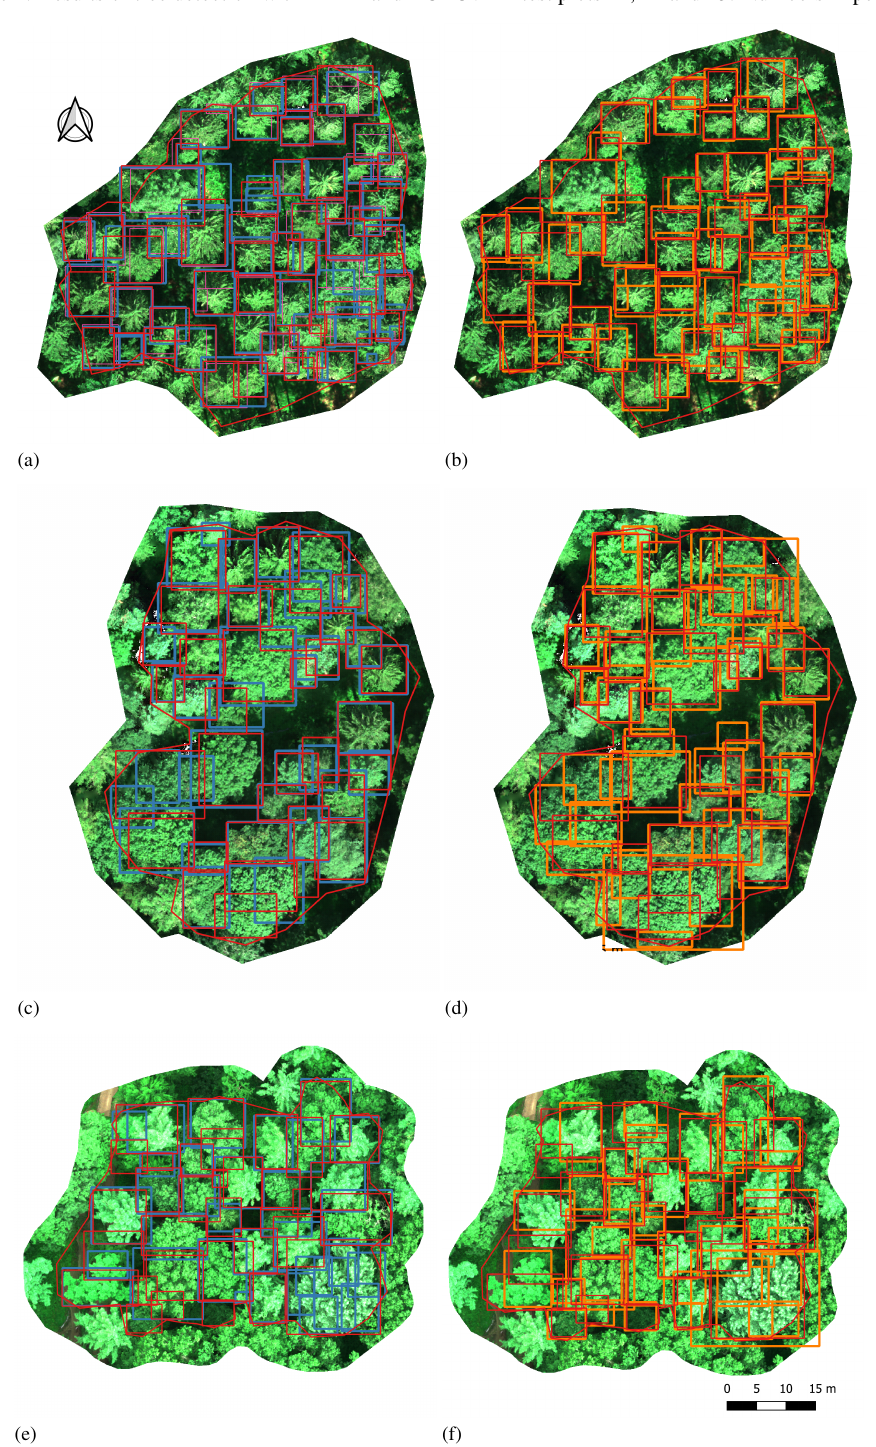
Figure 5. Results for object detection with DETR and YOLOv4. Reference data plot area surroundings are in red. Predicted bounding boxes are in blue (DETR) and orange (YOLOv4) respectively. a) Result of DETR for coniferous plot #1. b) Result of YOLOv4 for coniferous plot #1. c) Result of DETR for mixed plot #2. d) Result of YOLOv4 for mixed plot #2. e) Result of DETR for deciduous plot #3. f) Result of YOLOv4 for deciduous plot